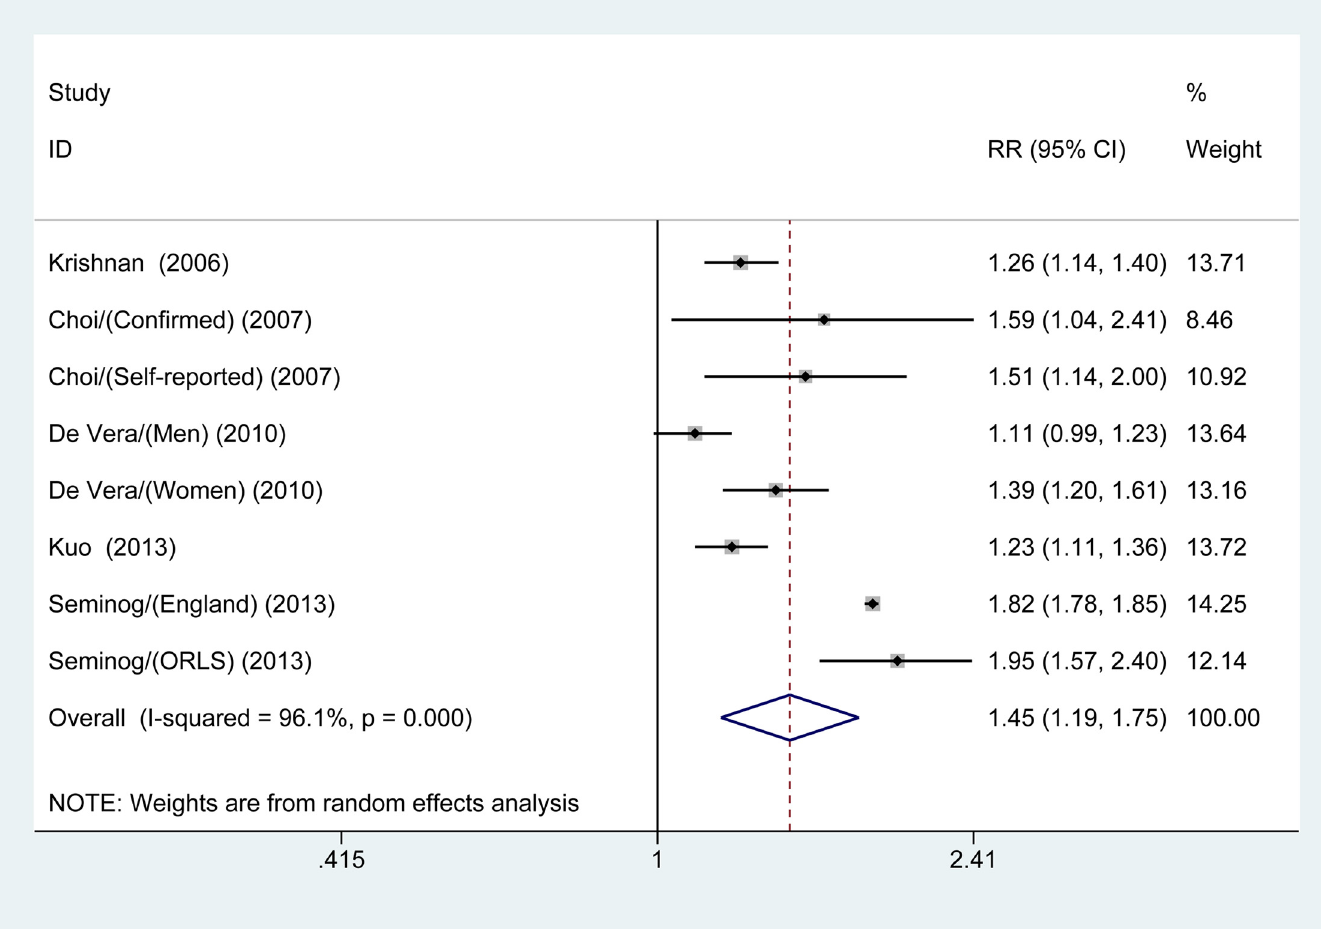
Fig 2. Forest plot showing the risk of myocardial infarction in patients with